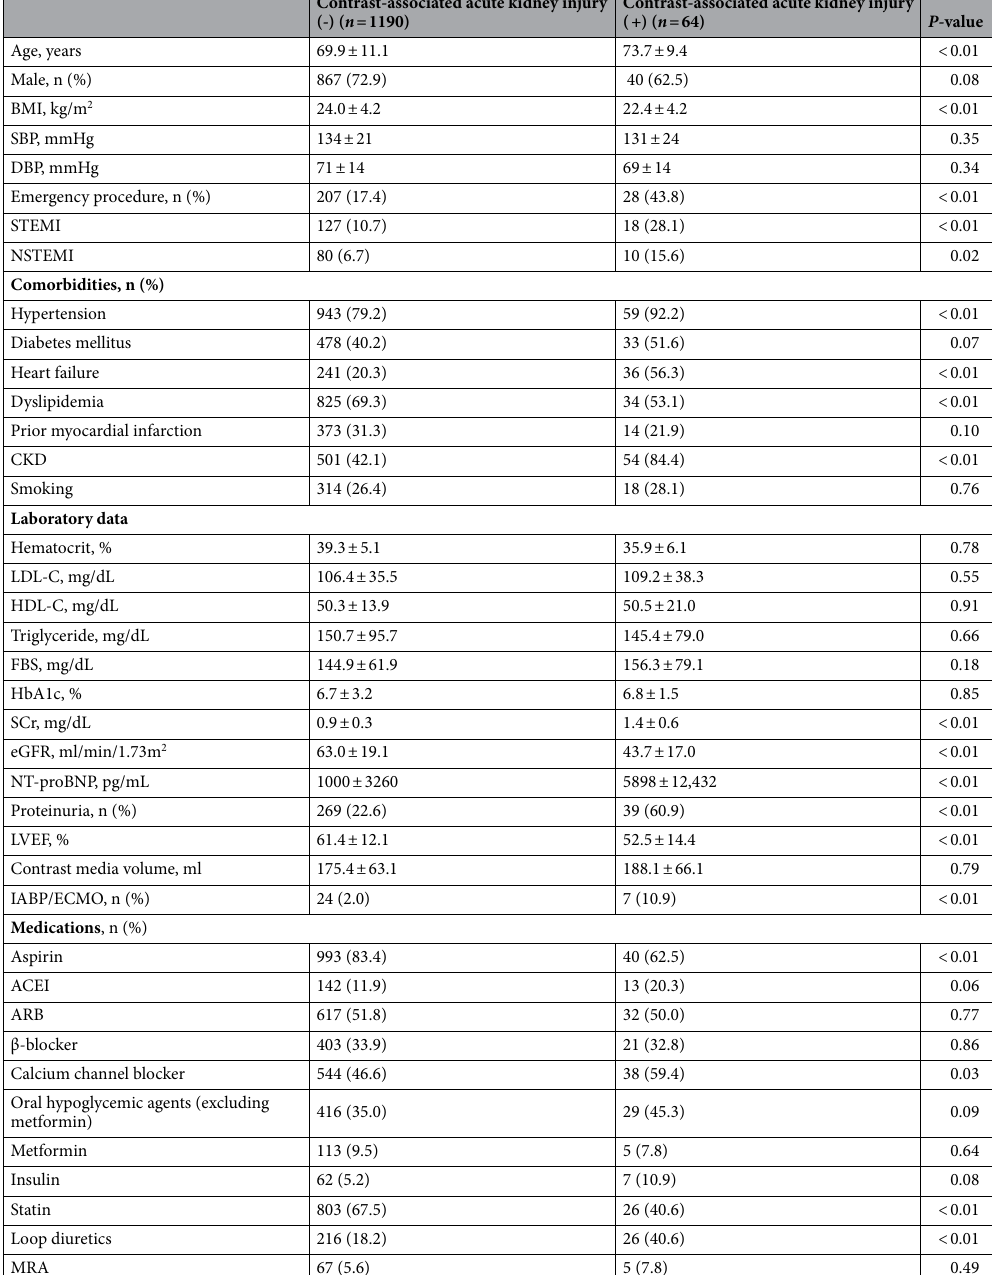
Table 1. Baseline characteristics. ACEI, angiotensin-converting enzyme inhibitor; ARB, angiotensin II receptor blocker; BMI, body mass index; CKD, chronic kidney disease; DBP, diastolic blood pressure; ECMO, extracorporeal membrane oxygenation; eGFR, estimated glomerular filtration rate; FBS, fasting blood sugar; HbA1c, hemoglobin A1c; HDL-C, high-density lipoprotein cholesterol; IABP, intra-aortic balloon pumping; LDL-C, low-density lipoprotein cholesterol; LVEF, left ventricular ejection fraction; MRA, mineralocorticoid receptor inhibitor; NSTEMI, non-ST elevation myocardial infarction; NT-proBNP, N-terminal pro-brain natriuretic peptide; Proteinuria, > = ( ±) by dipstick; SBP, systolic blood pressure; SCr, serum creatinine; STEMI, ST elevation myocardial infarction. Data are presented as the number, frequency, and mean ±